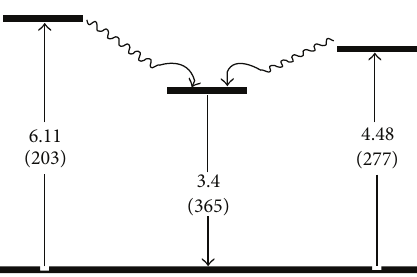
Scheme 1: Schematic diagram of energy levels explaining the fluorescenceemissionspectrumobservedforAgNCs.Energyvalues are given in eV (and nm inside